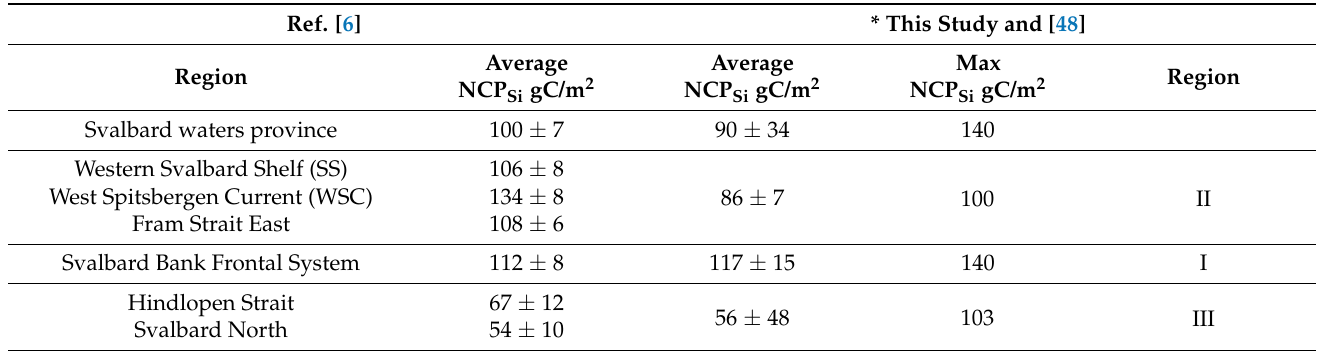
Table 4. Average primary production rates and standard deviations in regions of the Svalbard) (accumulated primary production in